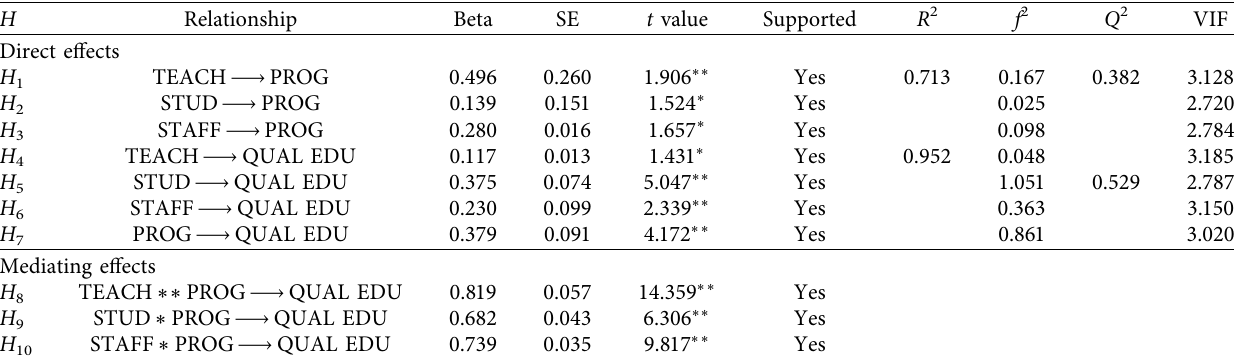
Table 1: Path analyses evaluation.